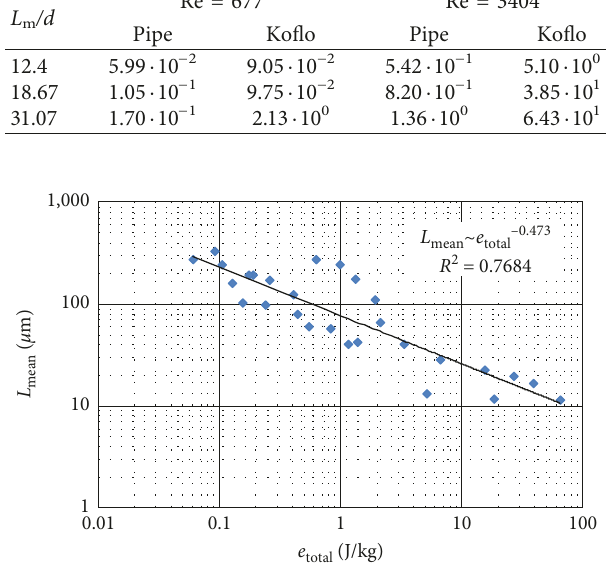
Figure 28: The mean crystal size as a function of the total de- struction energy.